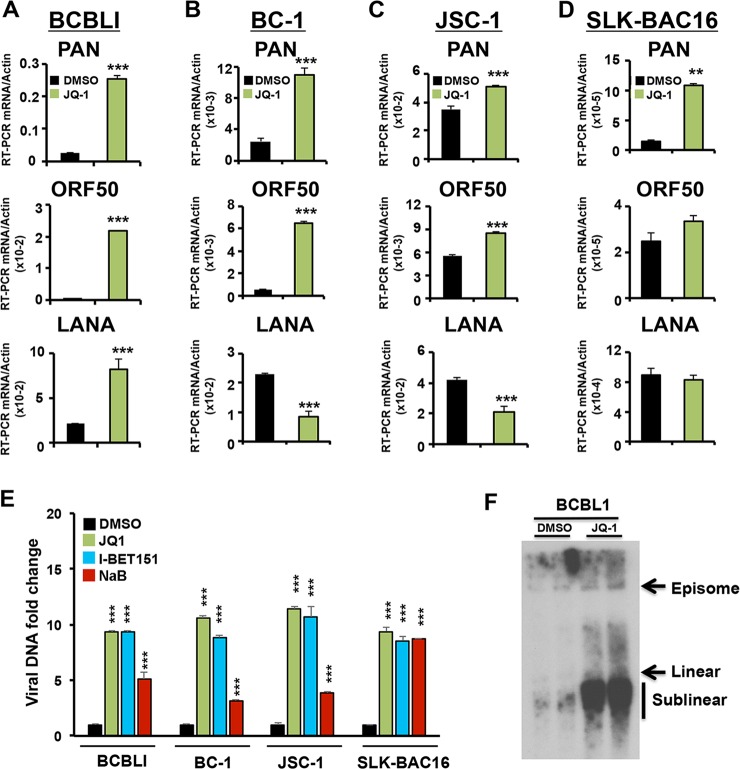
JQ1 induces KSHV lytic transcription and DNA replication in latently infected PEL cells.(A) RT-qPCR for PAN, ORF50 or LANA in BCLB1 cells treated daily for 72 hrs with 1% DMSO or 4 μM JQ1. (B) RT-qPCR as in panel A for BC-1 cells (C) JSC-1 cells or (D) SLK-BAC16 cells. ** P < 0.01 *** P < 0.001. (E) qPCR of KSHV genome in different cell lines treated as in (A) with DMSO, 4 μM JQ1, or 4 μM I-BET151, or 2mM NaB. The data are expressed as fold change of the treated versus untreated (DMSO) cells. *** P < 0.001 (F) PFGE analysis of BCBL1 cells treated as in panel A, and detected by Southern blot with probe specific for KSHV DNA. Electrophoretic positions for viral episomes, linear, and sublinear genomes are indicated.